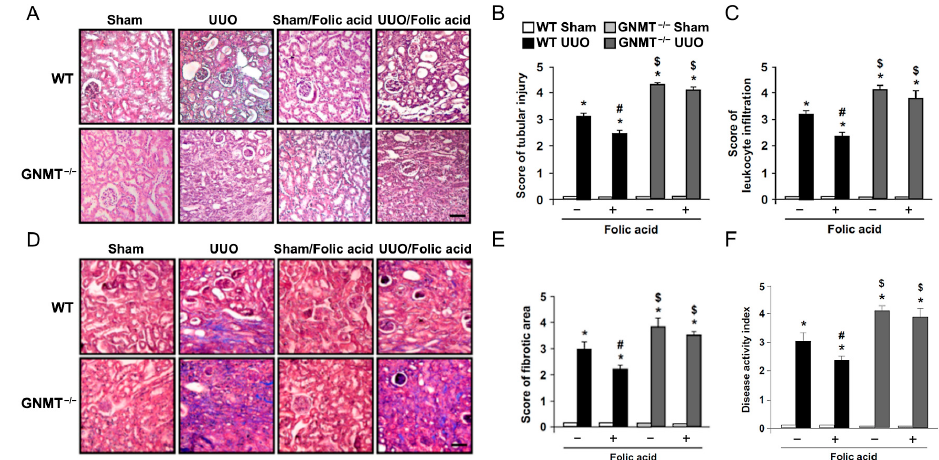
Figure 4. Effect of folic acid on UUO-induced renal tubular injury, leukocyte infiltration, and interstitial Figure 4. E ff ect of folic acid on UUO-induced renal tubular injury, leukocyte in fi ltration, and inter- fibrosis in WT and GNMT − / − mice. Paraffin-embedded kidney specimens were cut into 8 µ m sections stitial fi brosis in WT and GNMT − / − mice. Para ffi n-embedded kidney specimens were cut into 8 µm for histological examination. Magnification: 200 × . Scale bar: 50 µ m. ( A ) Representative hematoxylin sections for histological examination. Magni fi cation: 200×. Scale bar: 50 µm. ( A ) Representative he- and eosin staining of renal tubular injury and leukocyte infiltration of kidney tissue. Both the degree of matoxylin and eosin staining of renal tubular injury and leukocyte in fi ltration of kidney tissue. Both ( B ) renal tubular injury and ( C ) leukocyte infiltration were recorded. ( D ) Masson’s trichrome staining the degree of ( B ) renal tubular injury and ( C ) leukocyte in fi ltration were recorded. ( D ) Masson’s of collagen deposition in kidney tissue. ( E ) The degree of fibrotic area was recorded. ( F ) The average trichrome staining of collagen deposition in kidney tissue. ( E ) The degree of fi brotic area was rec- orded. ( F ) The average tubular injury, leukocyte in fi ltration, and fi brotic area scores were used as tubular injury, leukocyte infiltration, and fibrotic area scores were used as disease activity indices to disease activity indices to indicate the degree of renal injury. The data are presented as means ± indicate the degree of renal injury. The data are presented as means ± standard errors. * p < 0.05 standard errors. * p < 0.05 versus the sham group, # p < 0.05 versus non-folic acid-treated mice, $ p < versus the sham group, # p < 0.05 versus non-folic acid-treated mice, $ p < 0.05 versus WT 0.05 versus WT mice.